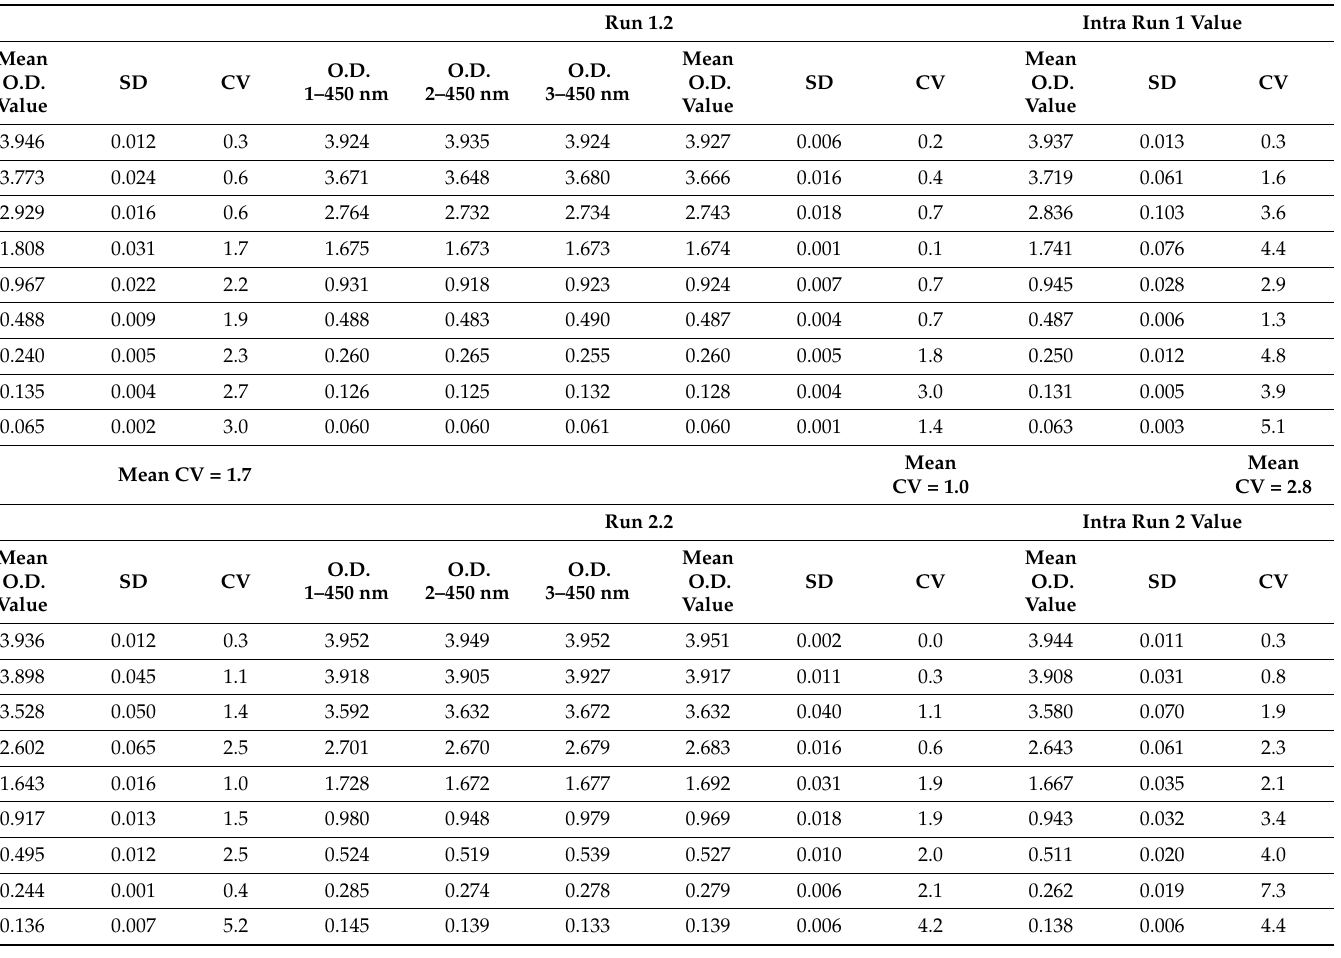
Table 1. Results for the various standard curves over the range of 1.953 ng/mL to 500